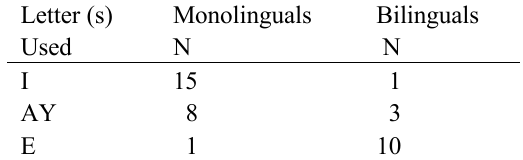
Table 17. Children’s misspellings for the phoneme / eɪ / in dake Letter (s) Monolinguals Used N